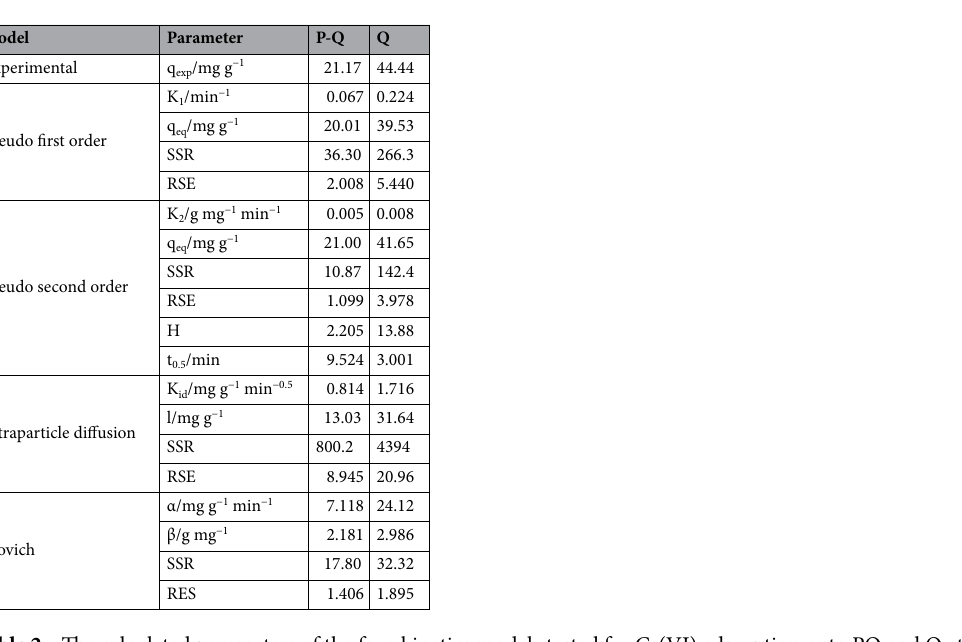
Table 2. The calculated parameters of the four kinetics models tested for Cr(VI) adsorption onto PQ and Q at different time intervals.